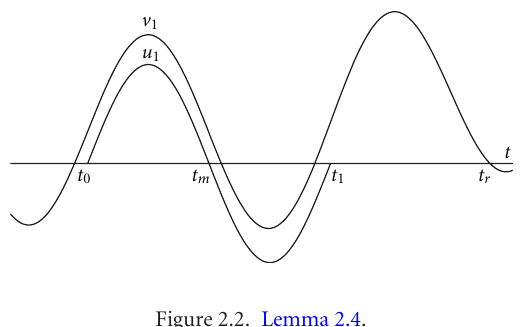
Figure 2.2. Lemma